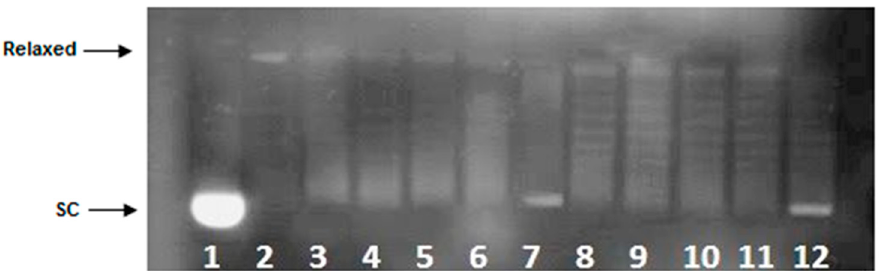
Figure 4. Influence of 2a on Topo I activity. The rate at which relaxed plasmid DNA was converted to supercoiled molecule was monitored over a time course of 30 min. Lane 1—supercoiled plasmid,